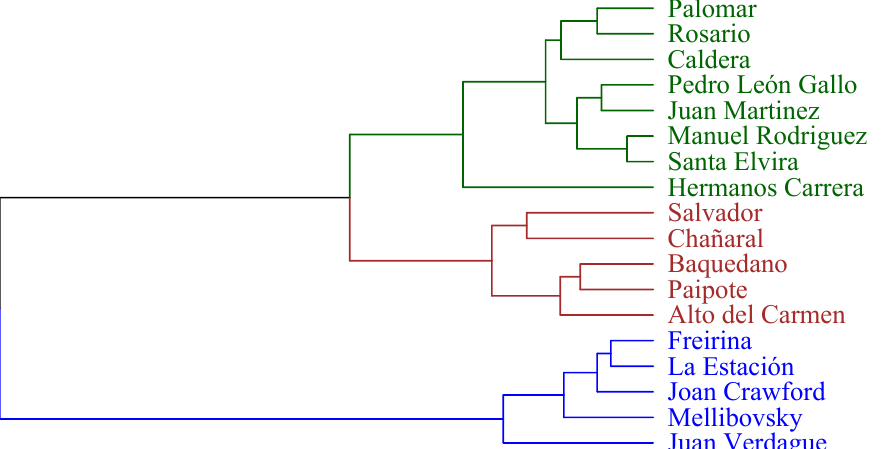
Figure 7. Hierarchical analysis: —highest compliance in the dimensions of the access chain and infrastructure, —lowest total compliance, —highest compliance in the participation and informa- tion